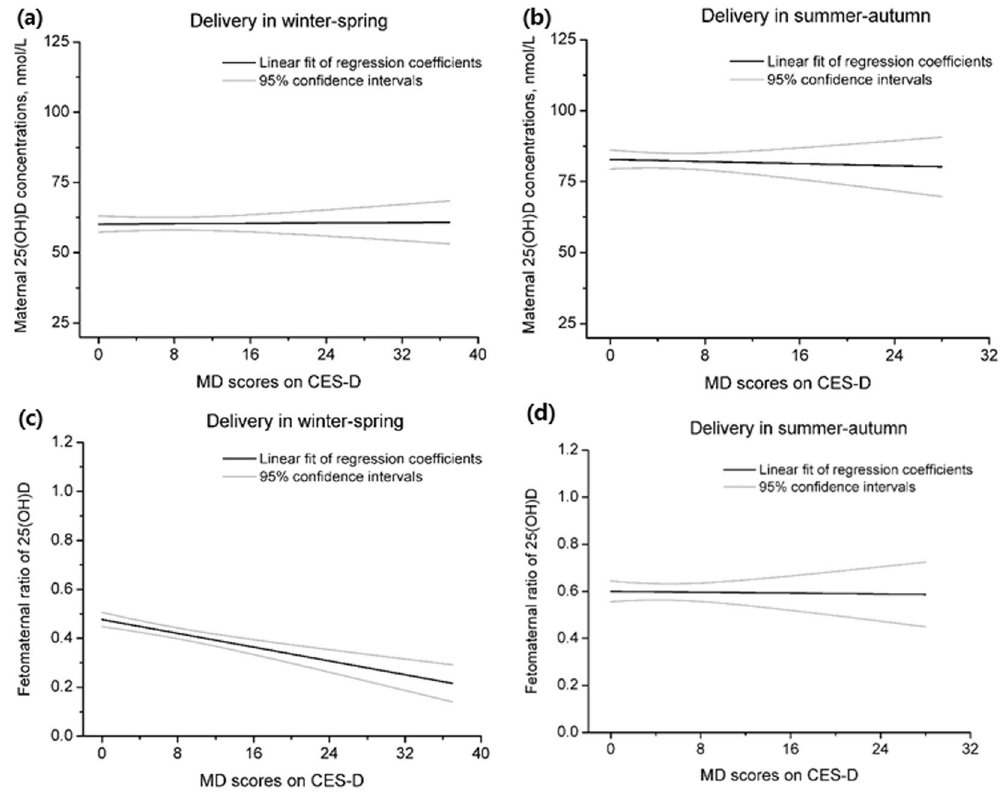
Figure 4. Linear associations of maternal depression (MD) score on CES-D with maternal 25(OH)D concentrations and the fetomaternal ratio of 25(OH)D concentrations. 25(OH)D, 25-hydroxyvitamin D; CES- D, Center for Epidemiological Studies Depression